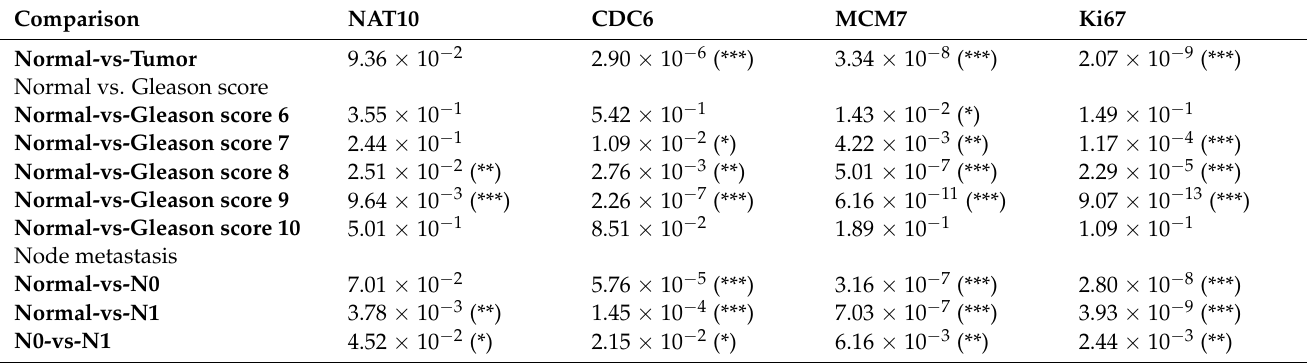
Table 1. Correlations between the expression of NAT10, CDC6, MCM7, or Ki67, and the clinicopatho- logical features of prostate cancers ( T -test; *, p < 0.05; **, p < 0.01; ***, p <